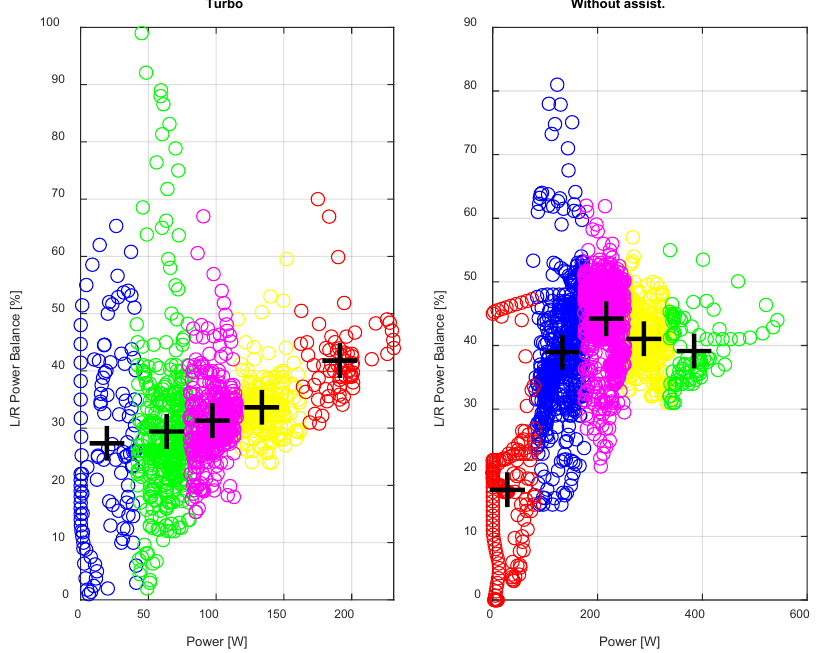
Figure 11. Left/right power balance.